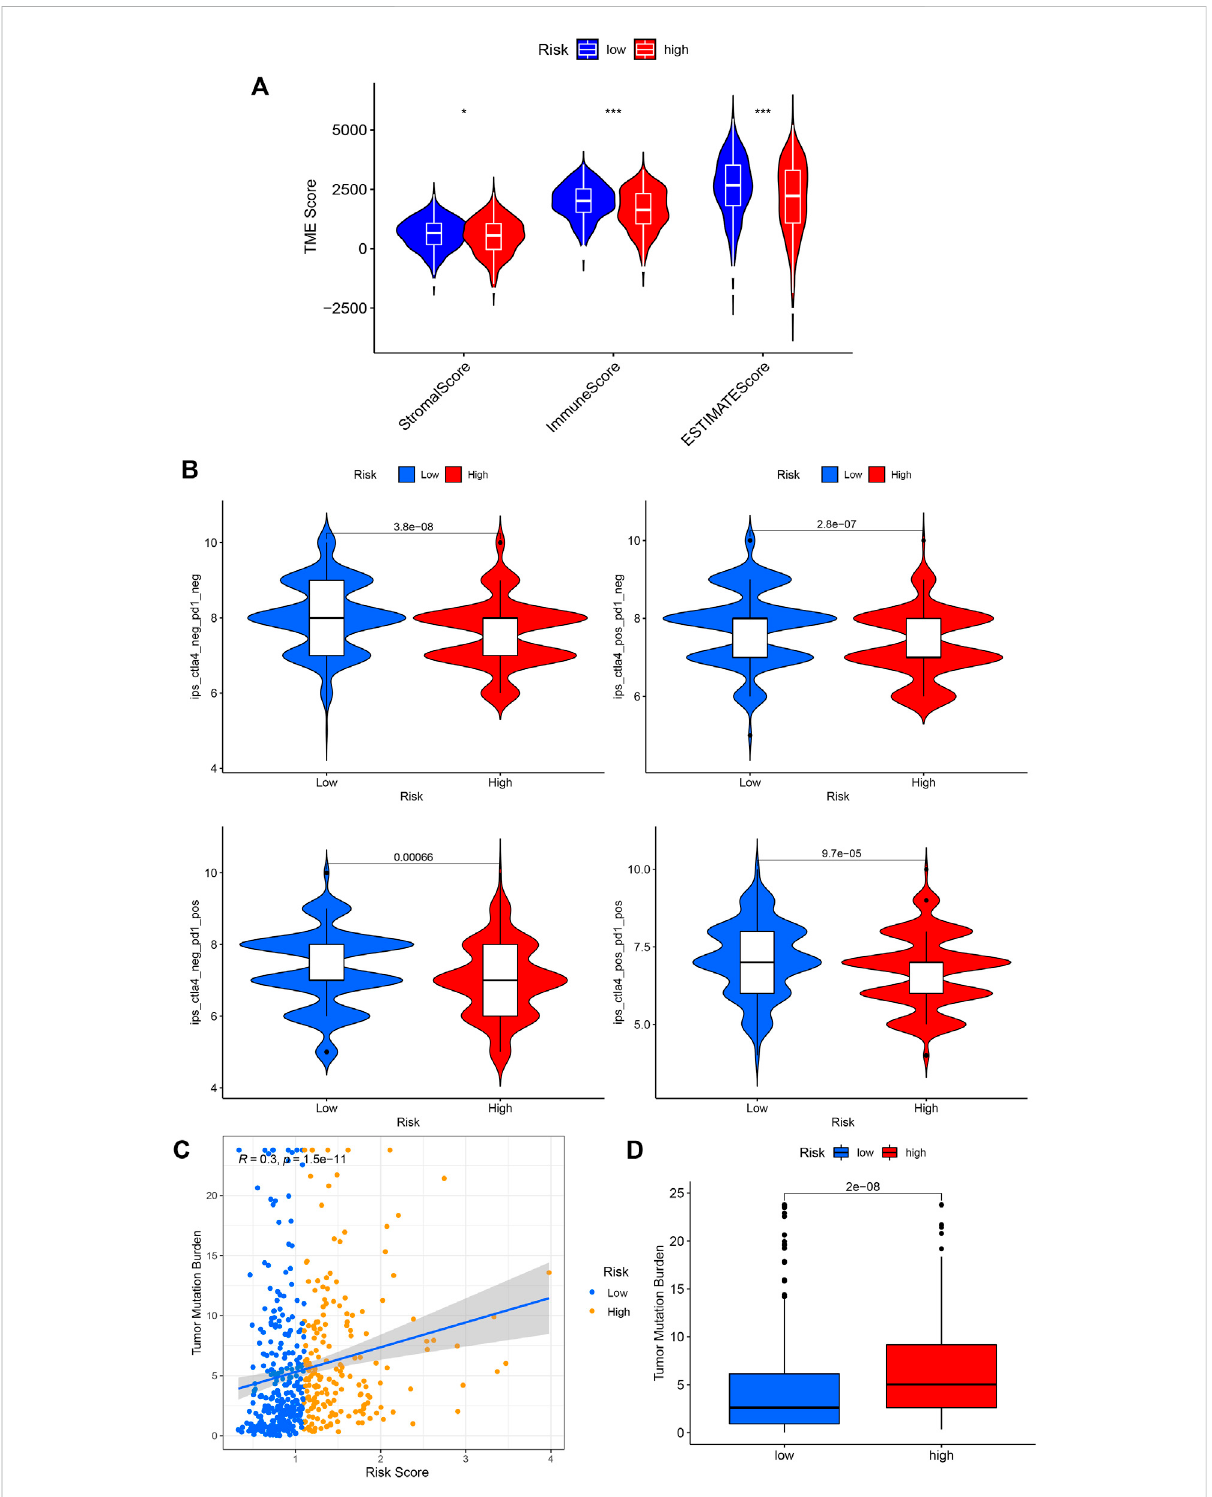
FIGURE 8 Application of risk score in predicting the immunotherapeutic effect. (A) Differential analysis of the tumor microenvironment for relative enrichment of immune cells and stromal cells. The low-risk group had a higher degree of immune cell in fi ltration and lower tumor purity. (B)